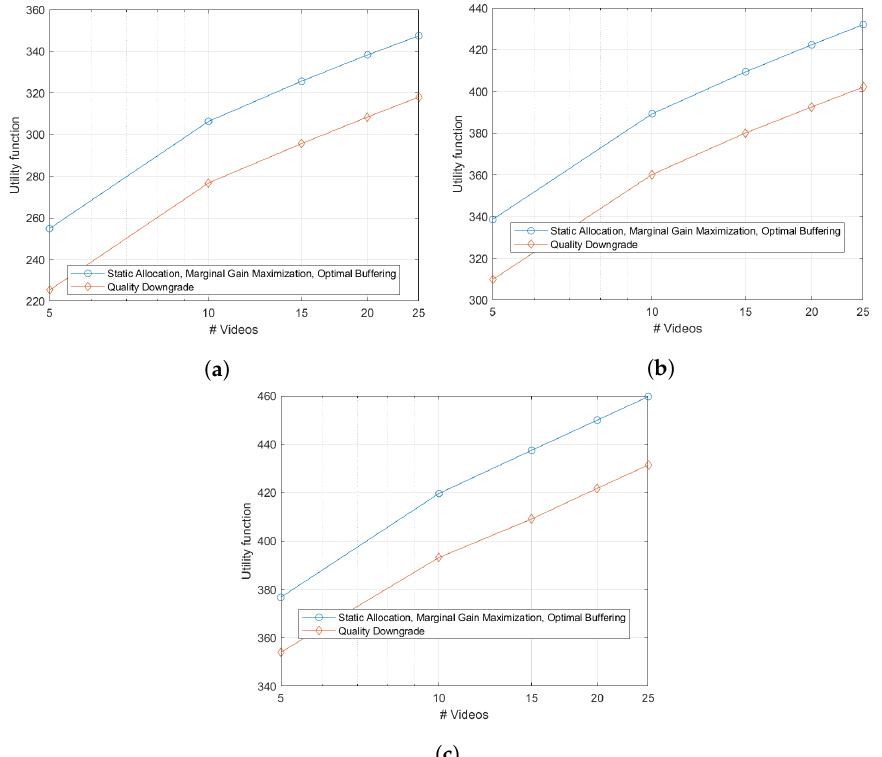
Figure 10. Utility function with variable number of videos. ( a ) Short videos. ( b ) Medium videos. ( c ) Long